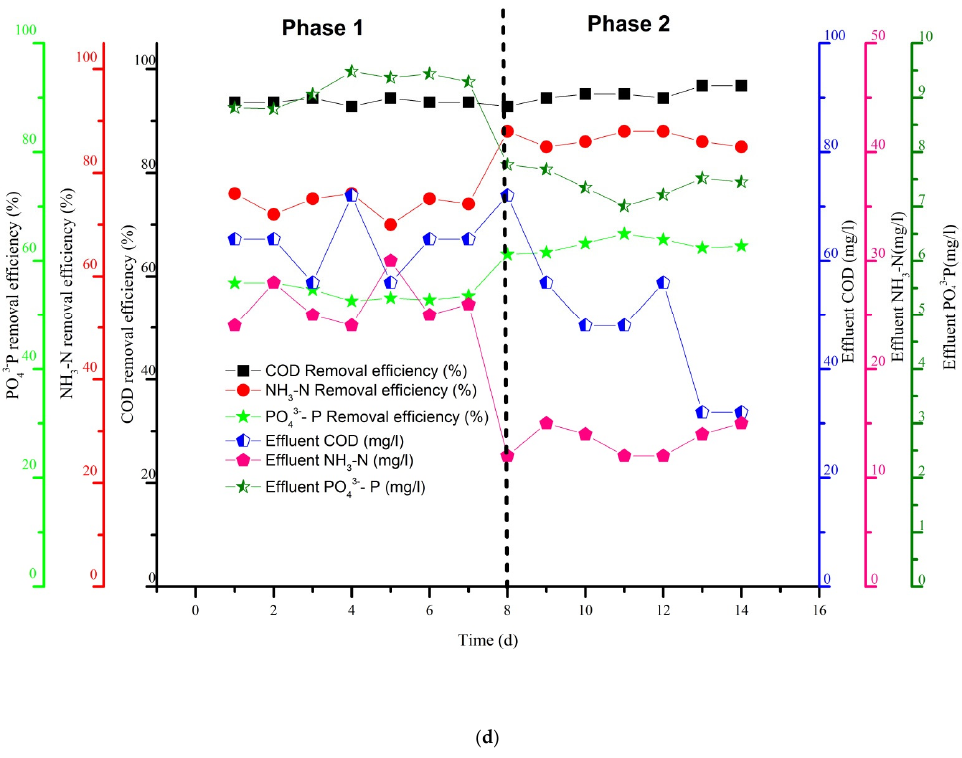
Figure 3. Time series degradation profile of COD, NH 3 -N and PO 43 − -P at different C:N:P ratios: ( a ) 100:5:2; ( b ) 100:5:1; ( c ) 100:10:1; and ( d ) 100:10:2.